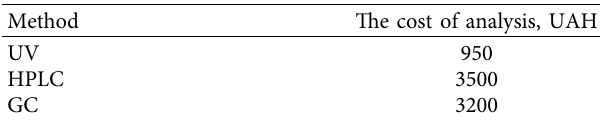
Table 7: The cost of one analysis of the content of BAC in the “VIROSAN F”